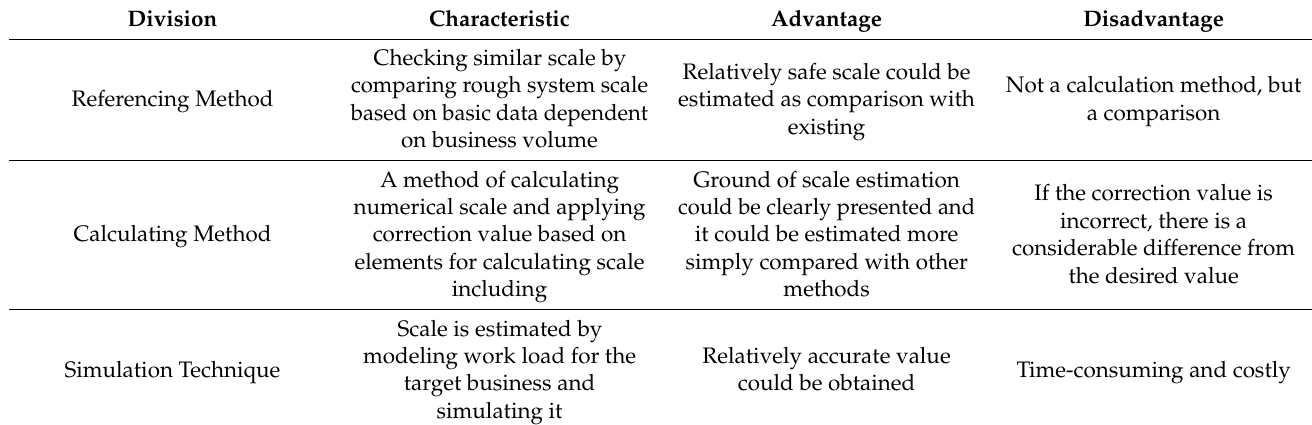
Table 4. Server sizing